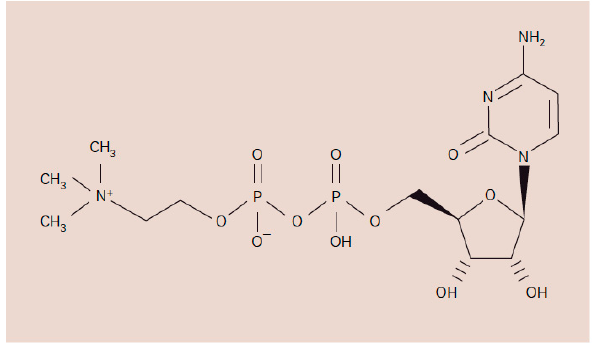
Figure 1. Chemical structure of Cytidine 5 ′ -Diphosphocholine or citicoline [4].